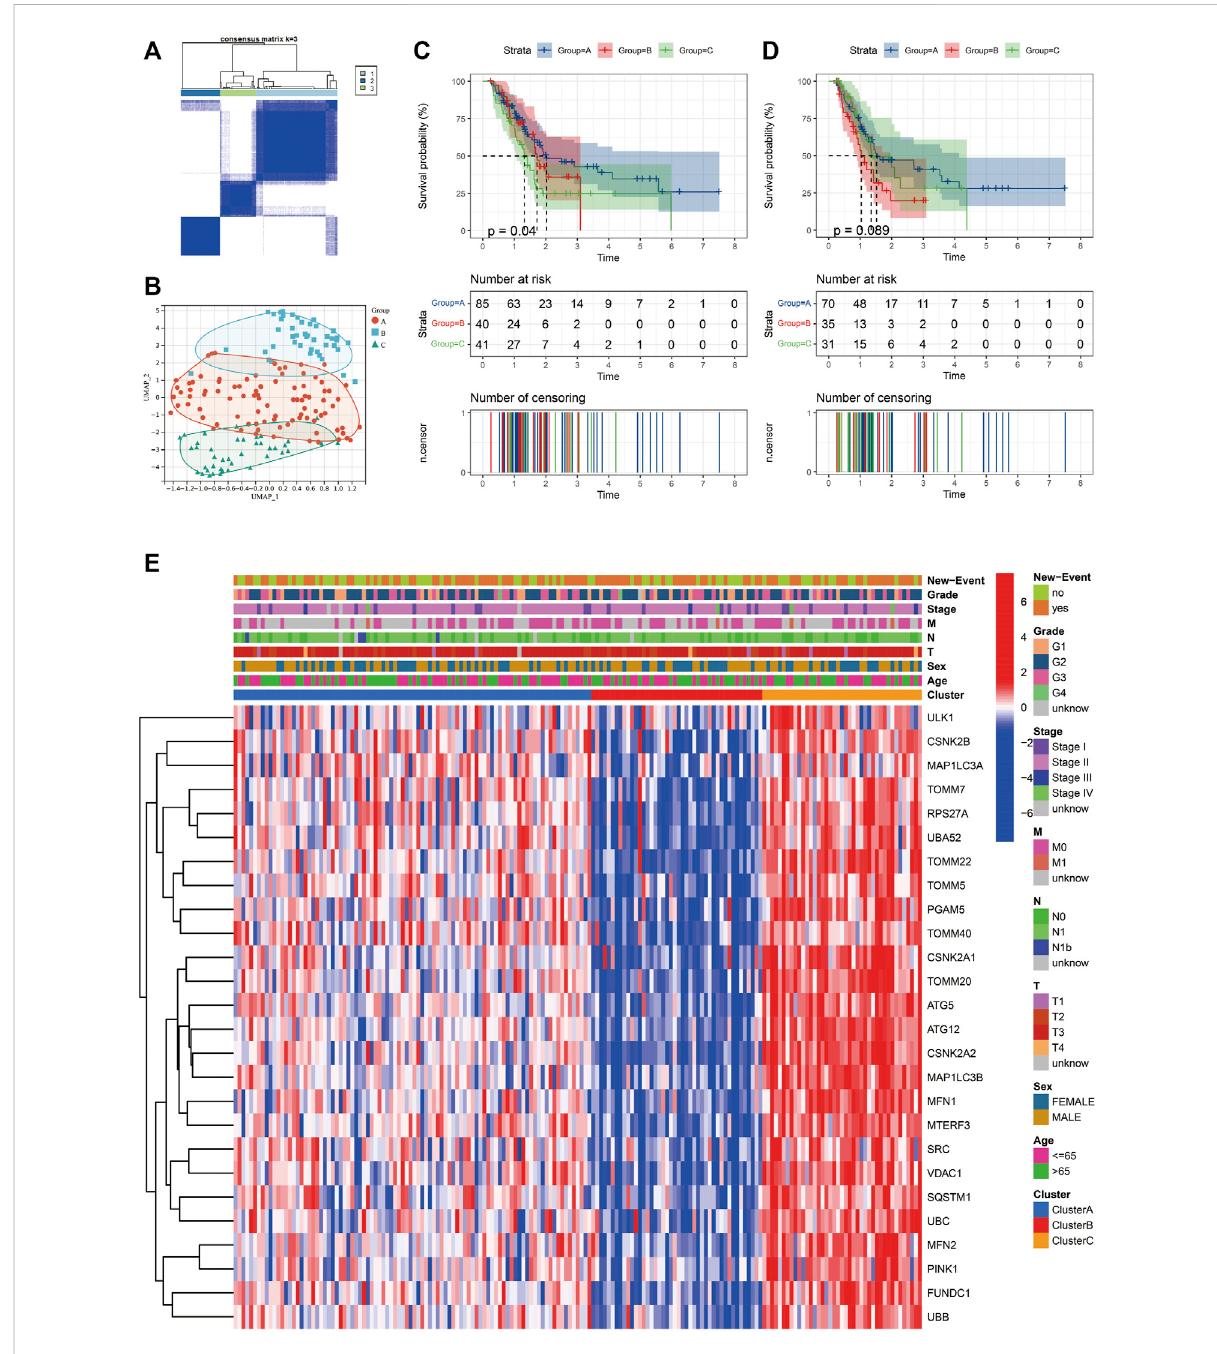
pro fi lesofmitophagyregulatorsarereducedtoUMAP1and2forvisualizationinTCGA-PAADcohort.K-ManalysesofOS (C) andPFS (D) fordifferent mitophagy subtypes in TCGA-PAAD. (E) Heat map comparing expression levels of mitophagy regulators among the 3 mitophagy subtypes.